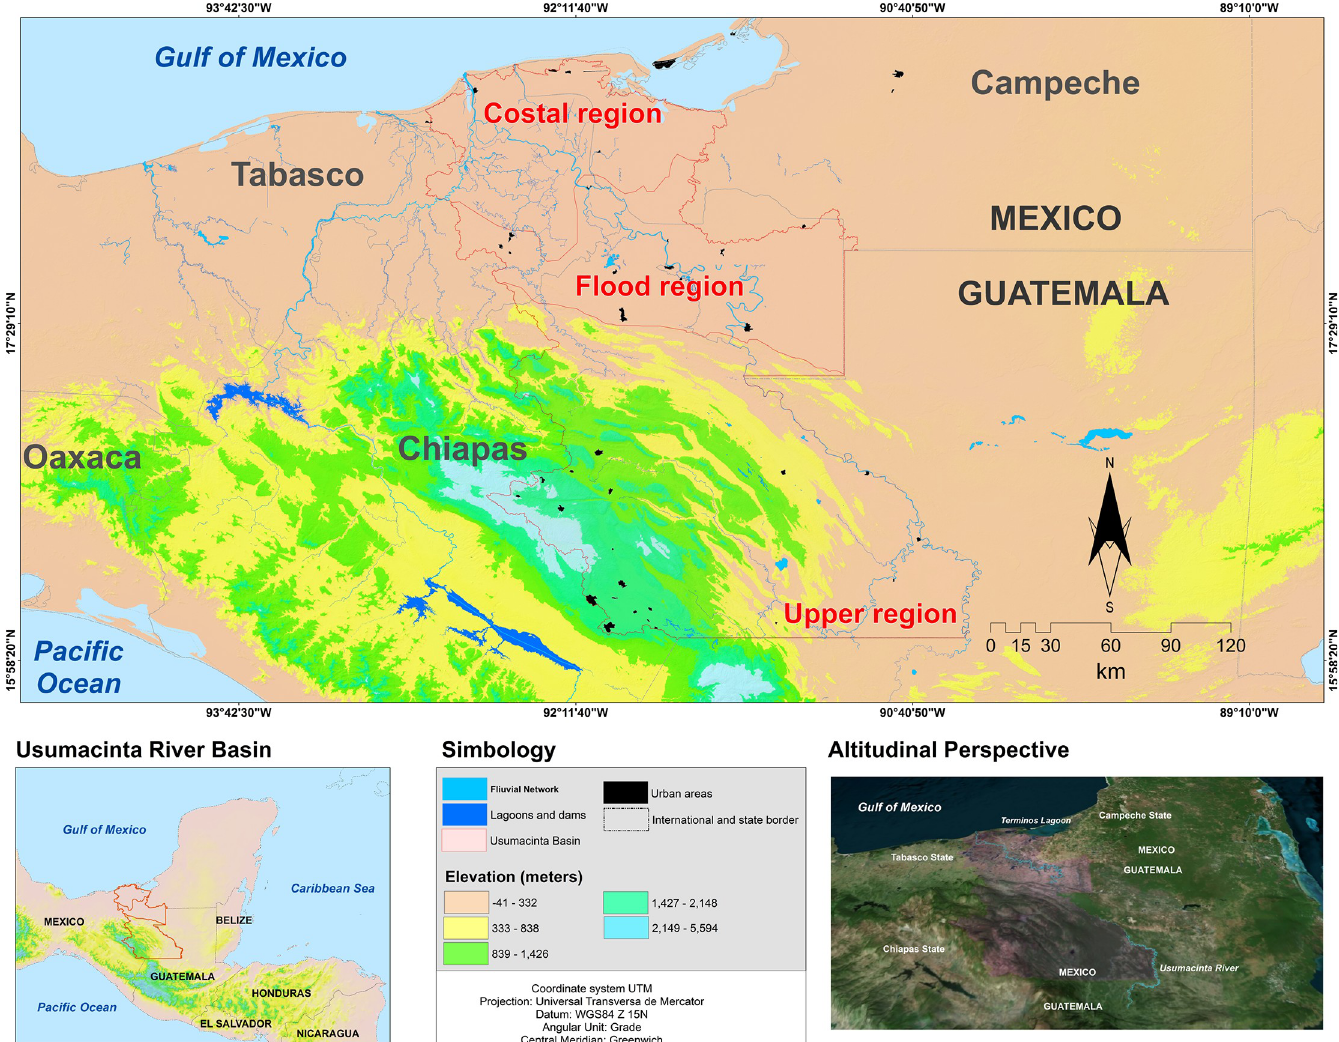
Fig 1. Study area. Basin of the Usumacinta River in Mexico. The study area consists of the complete area of the Usumacinta River Basin located in Mexican territory. While significant portions of the basin are located in Guatemala, the Mexican portion (study area) includes a marked physiographic and environmental gradient that divides the region into upper, middle, and lower